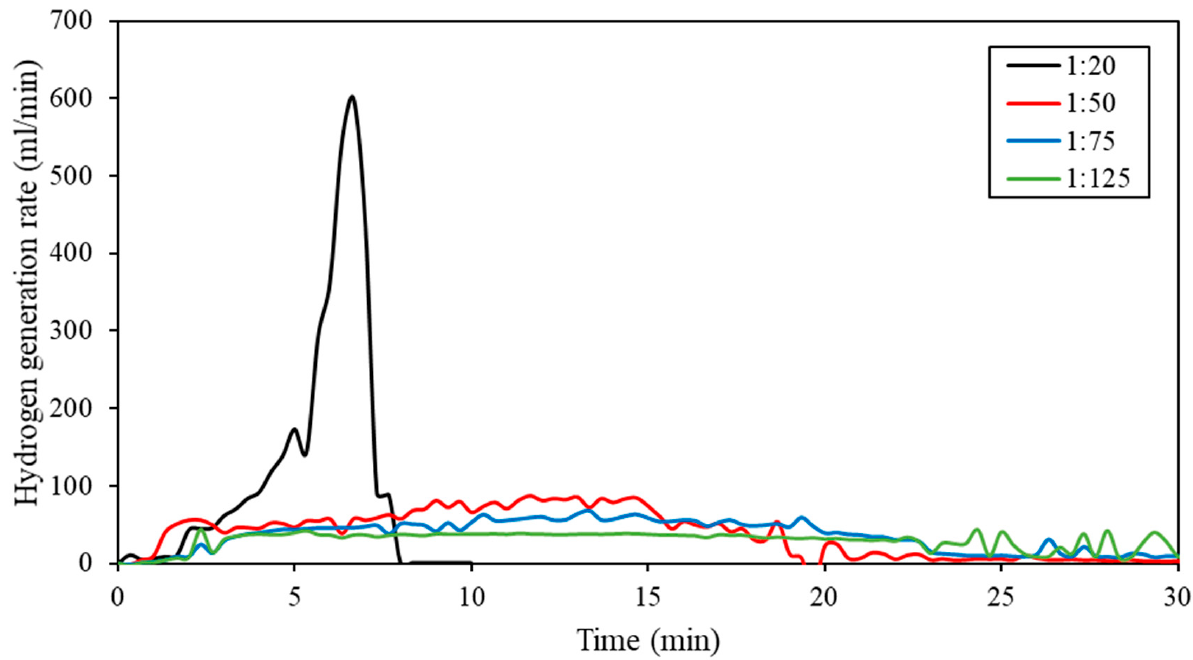
Figure 6. Hydrogen generation rates of Al-9.25% Bi-0.75% Ni composite hydrolyzed at different mass ratios (1:20 to